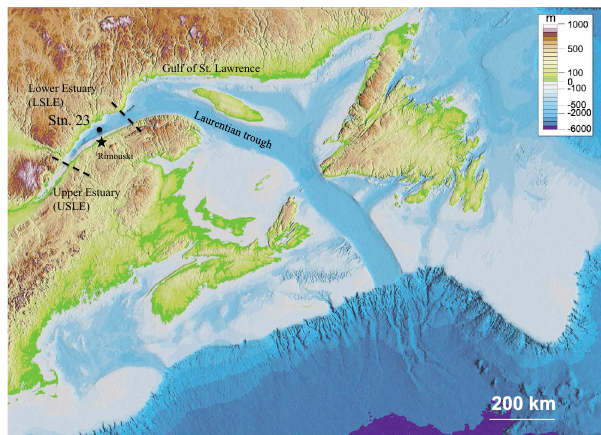
Fig. 2. Map of the St. Lawrence Estuary showing the location of Sta- tion 23 (48 ◦ 42.032 0 N, 68 ◦ 39.171 0 W; 345m depth), and delineating the extent of the Lower Estuary (LSLE). Modified from Shaw et al.